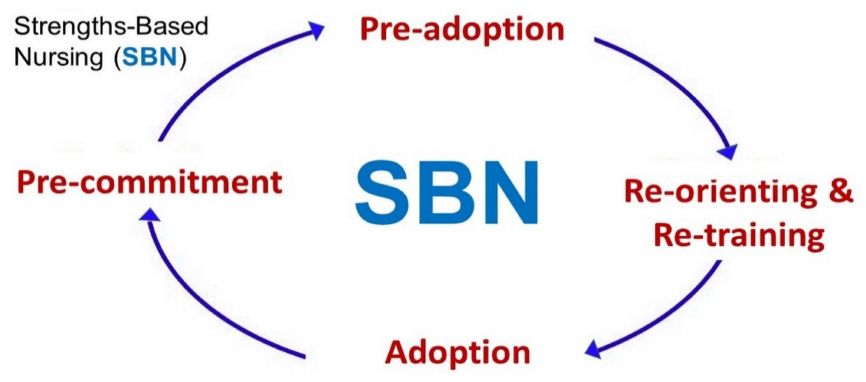
Figure 1. Steps involved in Strengths-Based Nursing